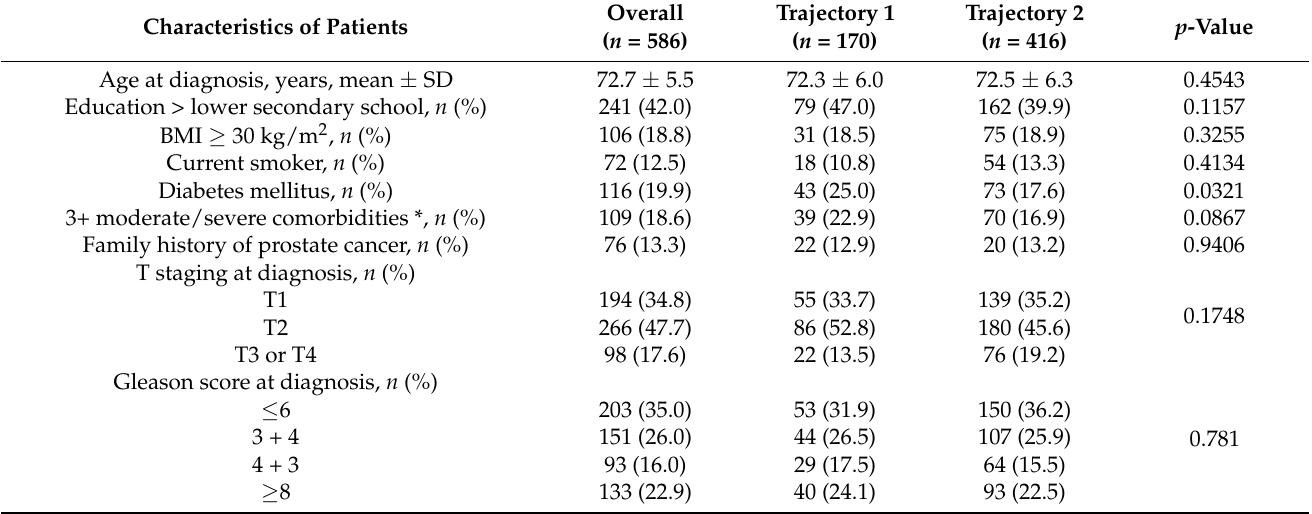
Table 2. Characteristics of patients according to the trajectories identified for BB. Characteristics of